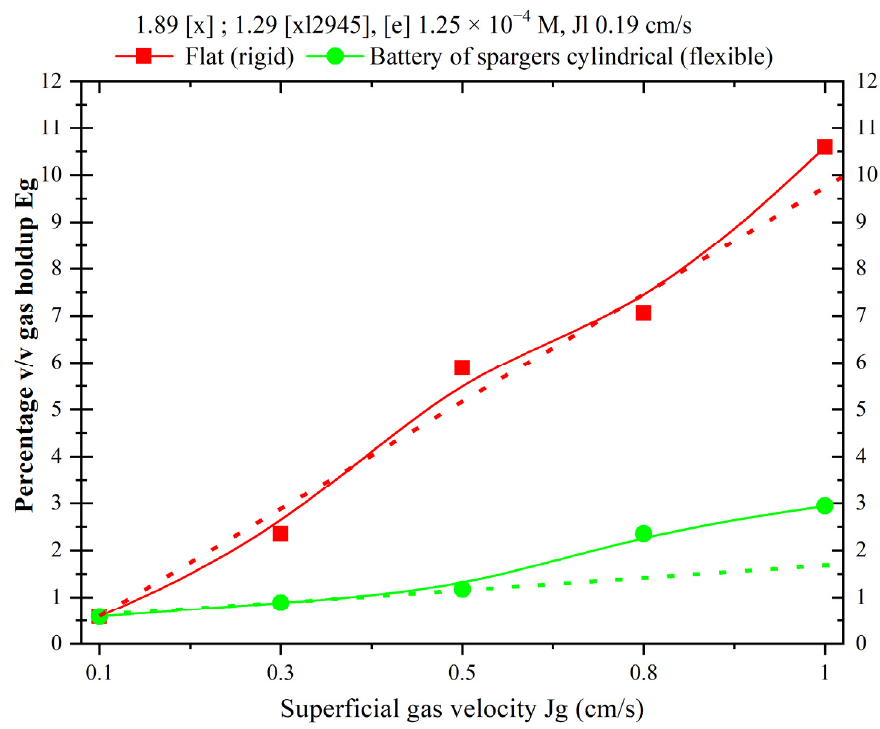
Figure 18. The effect of dispersion gas system percentage of v / v gas holdup as function of superficial gas velocity Jg (cm/s), 1.89 × 10 − 4 M [x], 1.29 × 10 − 4 M [xl2945], and [e] 1.25 × 10 − 4 M.